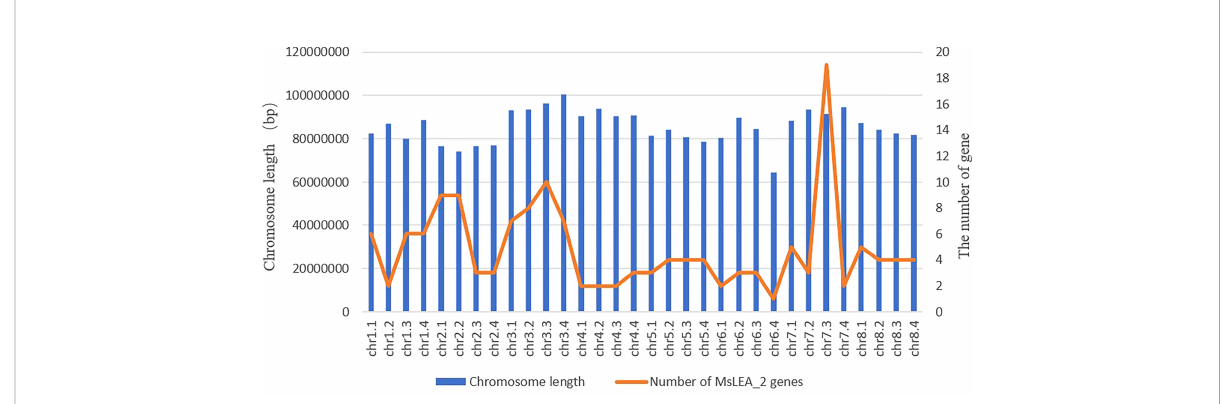
FIGURE 4 Chromosome length and number of MsLEA_2 gene family members. The blue columns represent the length of chromosomes, the orange fold line denote the number of MsLEA_2 genes in every